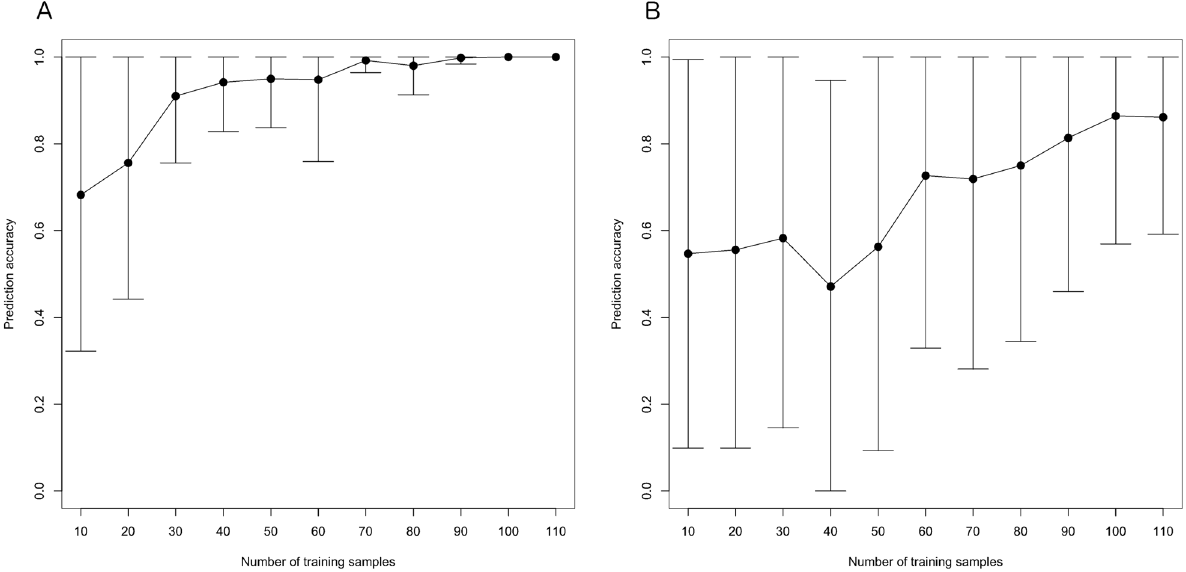
Figure 3. Plots showing the mean and standard deviation accuracy of sex prediction on two external datasets using a predictor trained using different sample sizes from our dataset. We built predictors using different training sample sizes ranging from n=10 (5 R , 5 = ) to n=110 (55 R , 55 = ) from our full dataset. We then calculated the prediction accuracy, for each n (=10…110) on two external datasets (A. Dataset GSE24215 and B. Dataset GSE23697). This was repeated 50 times and the mean and standard deviation prediction accuracy for each sample size was calculated. As the training sample size increased, so did prediction accuracy on the external datasets.